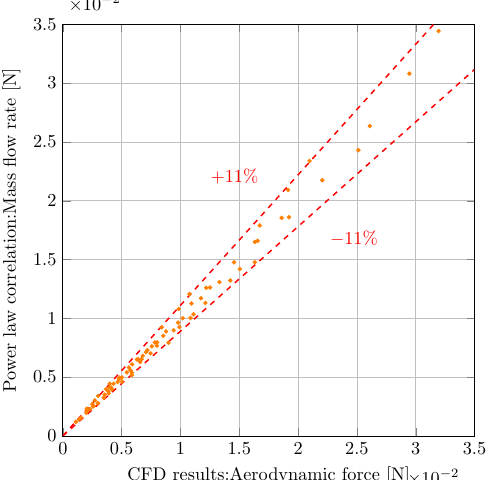
Figure 20. Pressure force empirical model: CFD simulations versus empirical model.